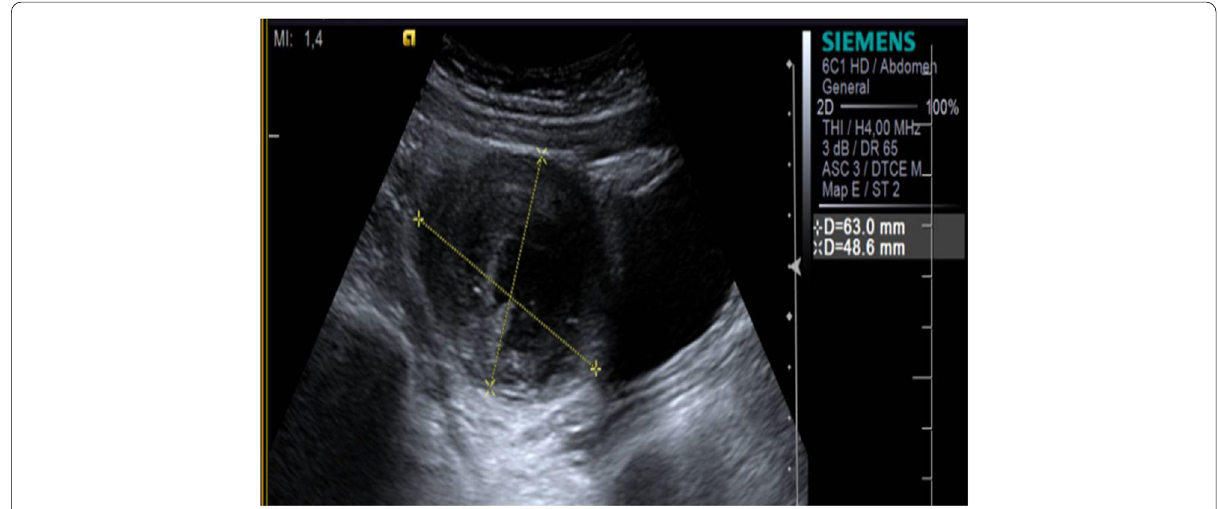
Fig. 1 USG image: 63